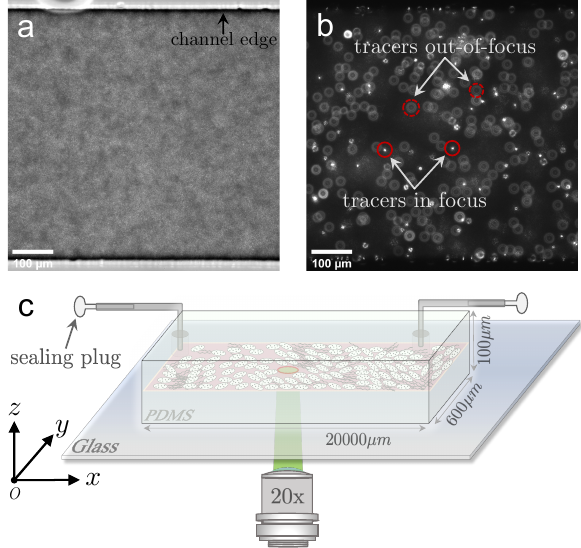
Figure 1. Experimental setup. ( a ) Bright-field snapshot of bacterial suspension in high concentration and ( b ) typical fluorescent snapshot of the tracer particles seeded in bacterial suspension. ( c ) Sketch of PDMS microfluidic channel with the dimension of 600 µ m, 100 µ m and 20 mm in width, height and total length, respectively. The entrance and outlet of the channel are sealed at the tubing ends after imposing bacterial suspension into the